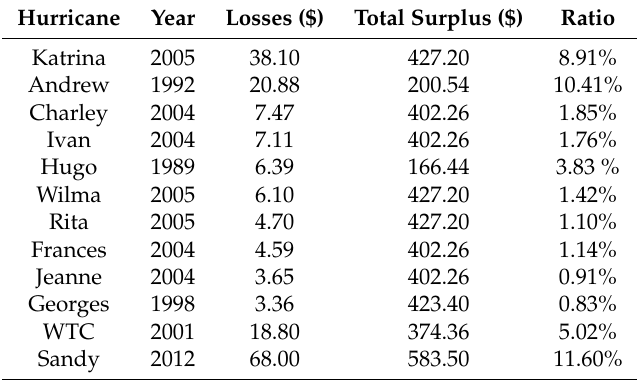
Table 3. Top ten insured losses in current dollars and as a fraction of policyholders surplus (source: ISO; I.I.I.). Losses and total surplus are in billions of current dollars. WTC is the World Trade Center attack, here considered as a stressor equivalent to